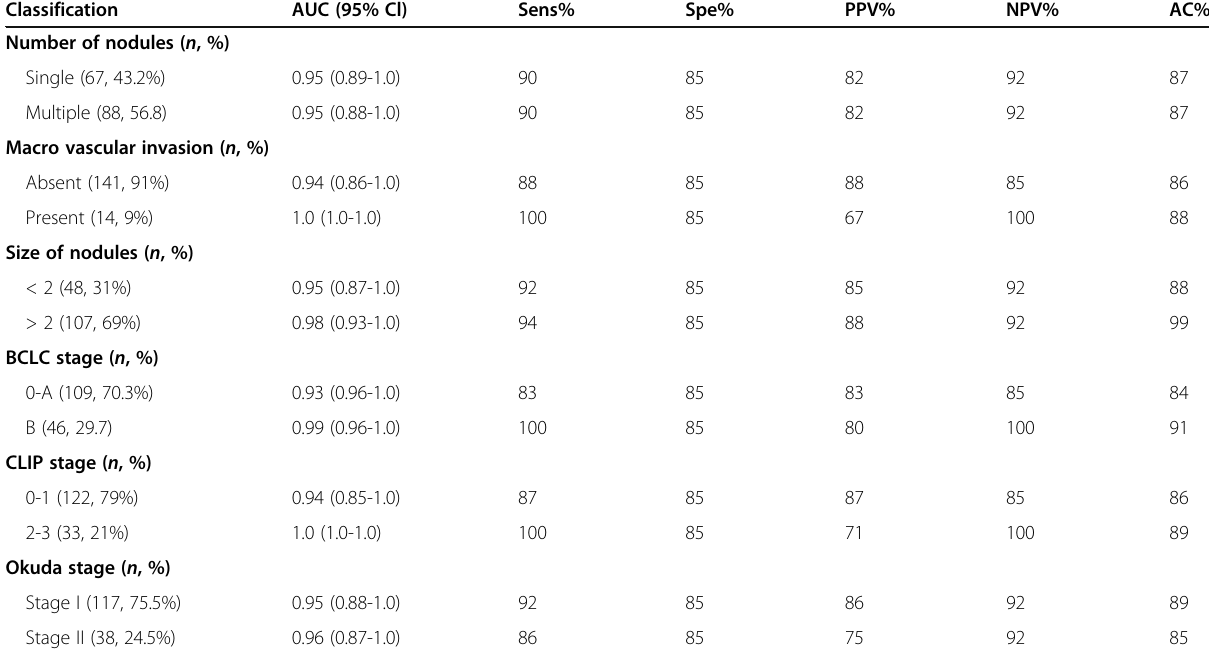
Table 7 Performance of the four-marker model (IGF2+ IL6+ AFP+ platelet count) according to the BCLC, CLIP, and Okuda staging